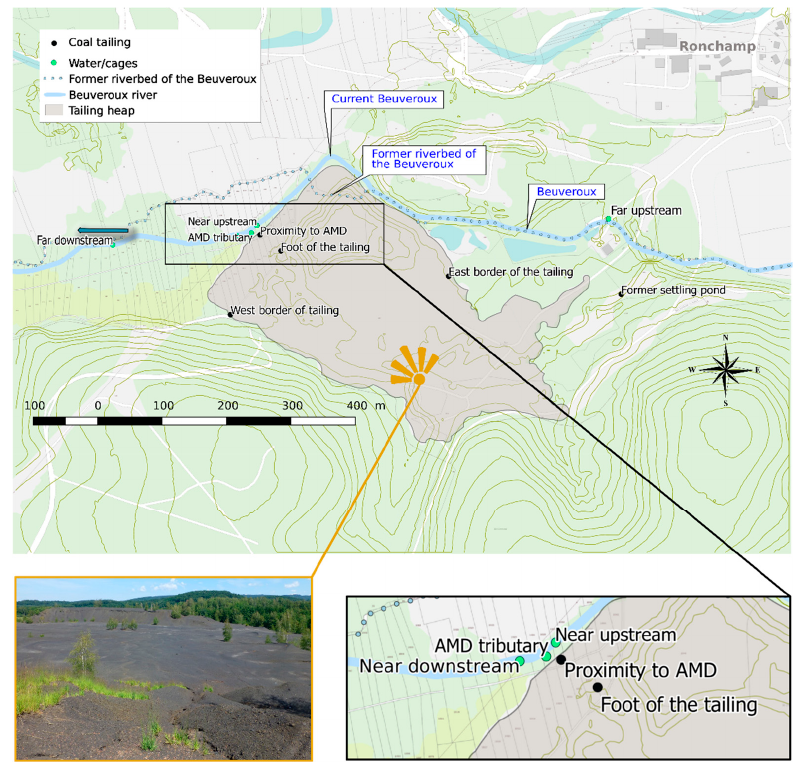
Figure 1. Map of the study area, presenting the coal tailing sampling stations over the heap (black points) and the water sampling/caging stations in the Beuveroux river (turquoise points) .